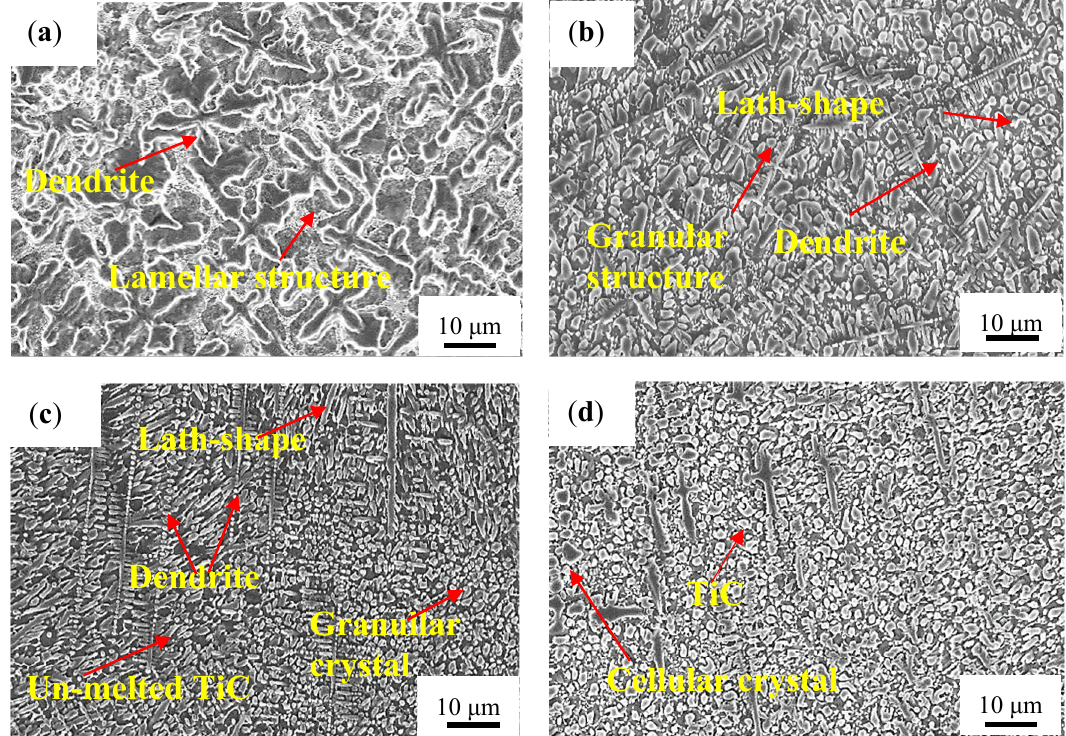
Figure 5. Morphologies at the middle of coatings on the cross section. ( a ) Ti-Al-Si, ( b ) Ti-Al-Si-2TiC, ( c ) Ti-Al-Si-6TiC and ( d ) Ti-Al-Si-10TiC.